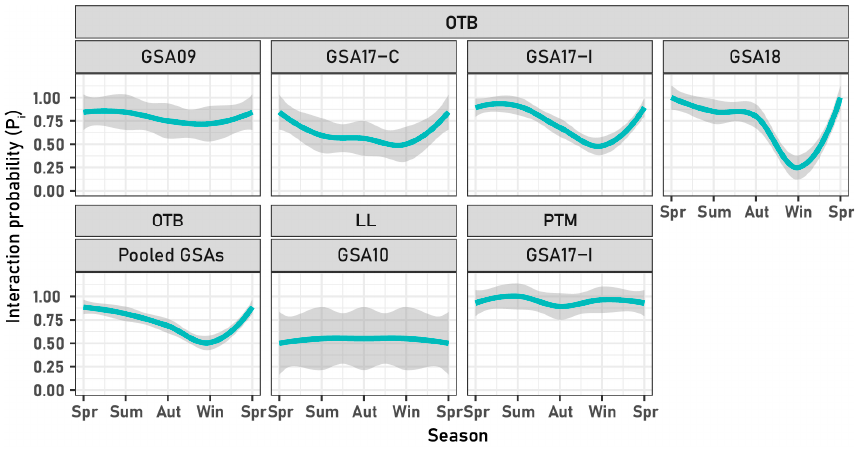
Figure 2. Interaction probability ( P i %) between dolphins and fishing activities throughout the seasons in the different Geographical Sub Areas (GSAs) for the set nets (GEN). The cyan line represents the average trend, while the grey shadowed areas represent the 95% confidence intervals.